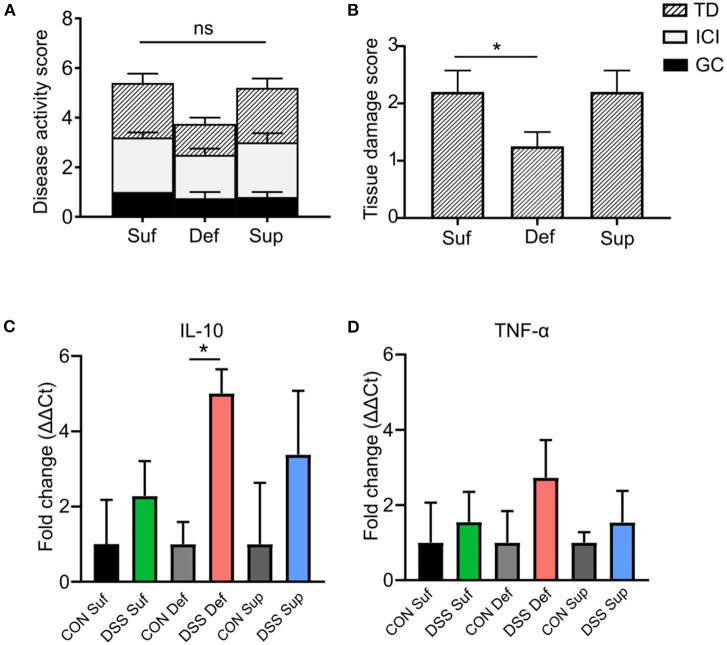
Vitamin B12 deficiency affects DSS-induced colitis tissue damage. (A) Composite histopathology scores of colonic tissues, graded by tissue damage (TD), inflammatory cell infiltrates (ICI) and loss of goblet cells (GC). (B) Tissue damage score between B12 dietary groups post DSS-treatment, B12 deficient pups show decreased tissue damage (One-way ANOVA, P = 0.021, n = 5). Normalized mRNA fold change expression ΔΔCt, between control mice and DSS treated mice. (C) Anti-inflammatory cytokine IL-10. Significant increase in IL-10 between B12 deficient mice post DSS compared to control (unpaired t-test, n = 3, P = 0.005). (D) Pro-inflammatory TNF-α, increased post DSS in all treatment groups but no significant difference between treatment group was found. Statisticall signigicance represented as *p < 0.05. Values are expressed as means + SEM.